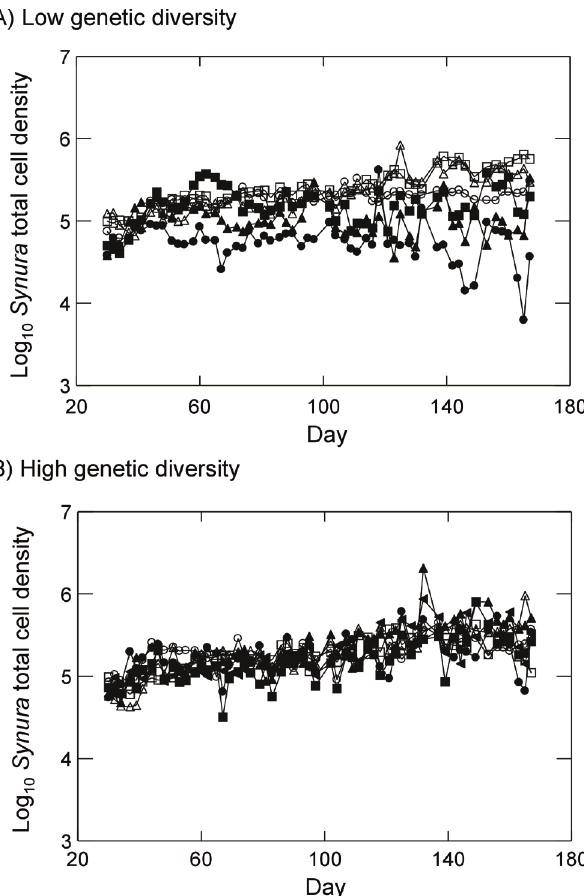
Figure 3. Effects of initial Synura genetic diversity (low versus high) on ( A ) detrended temporal variability of Brachionus populations (an inverse measure of stability), measured as mean residuals from linear regressions of log transformed Brachionus density versus time, and ( B ) Brachionus densities averaged over the course of the experiment. Both measures ( A and B ) were based on dynamics over days 51 to 167. Shown are means (+/- S.E.). Original units in numbers of individuals per mL.